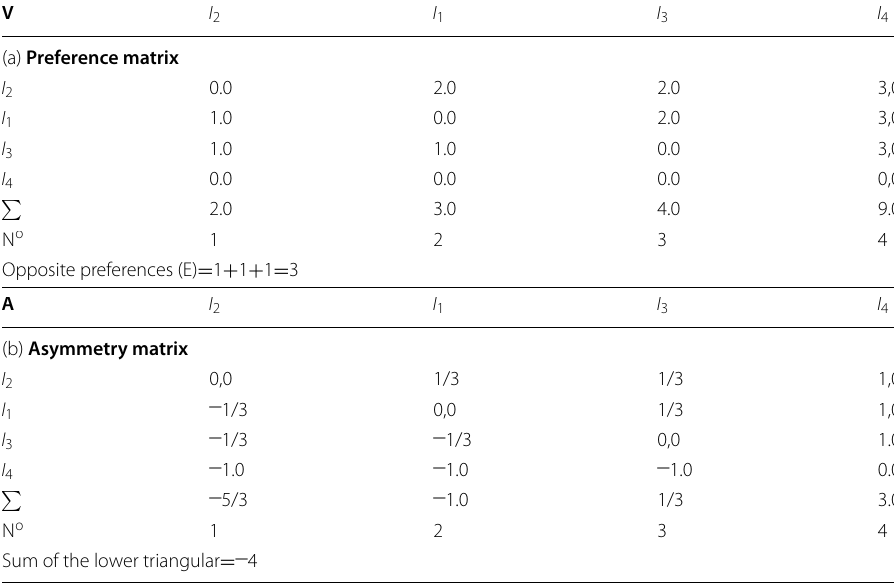
(cid:31) Sum of the lower triangular